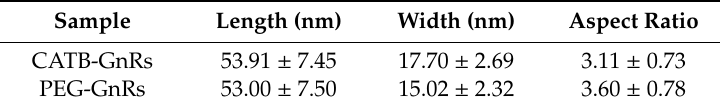
Table 1. Physical characterization of GnRs (mean ± SD, n =